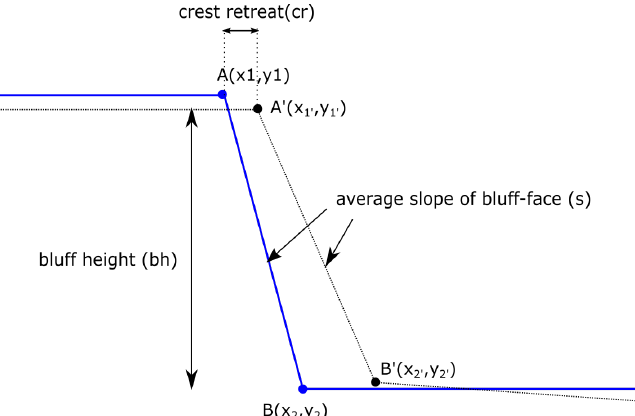
Figure 9. Definition of the horizontal crest retreat ( cr ), the average slope of the bluff-face ( s ) and the height of the bluff ( bh ). The bluff retreated from A’B’ line to now AB line. The crest retreated from point A’( x 1 (cid:48) , y 1 (cid:48) ) to A( x 1 , y 1 ) whereas the base retreated from B’( x 2 (cid:48) , y 2 (cid:48) ) to B( x 1 , y 1 ).